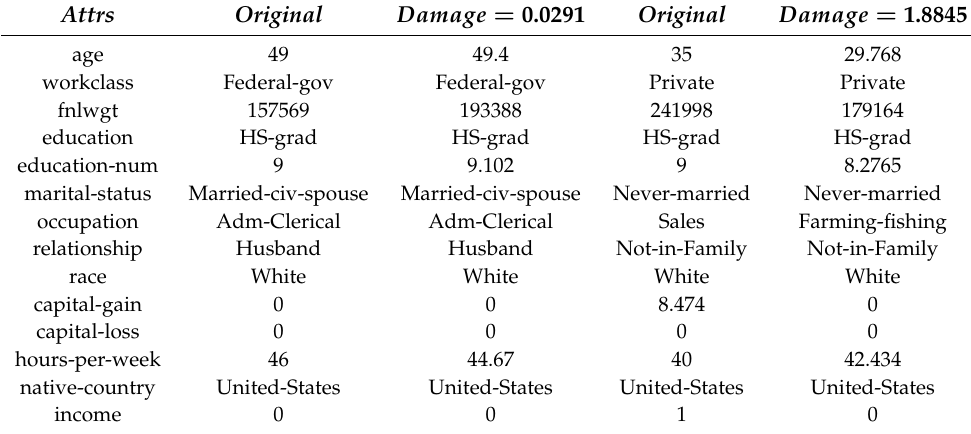
Table A5. Minimally damaged profile, profile with damage at 50% of the max at α = 0.9875 for the first fold.